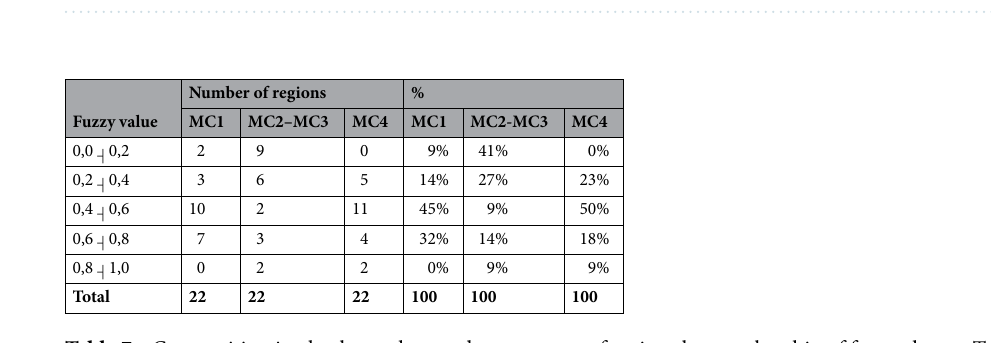
Table 7. Composition in absolute values and percentages of regions by membership of fuzzy classes. Total values are in